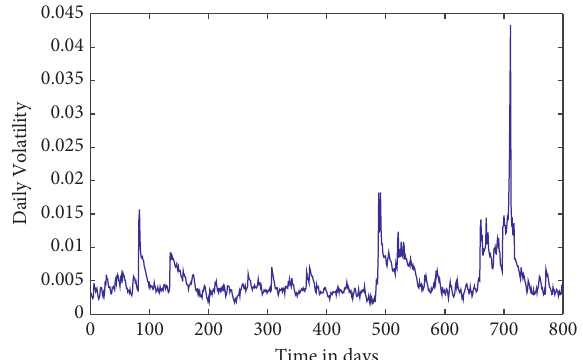
Figure 8: The estimated volatility of daily S&P 500 data for T � 800.